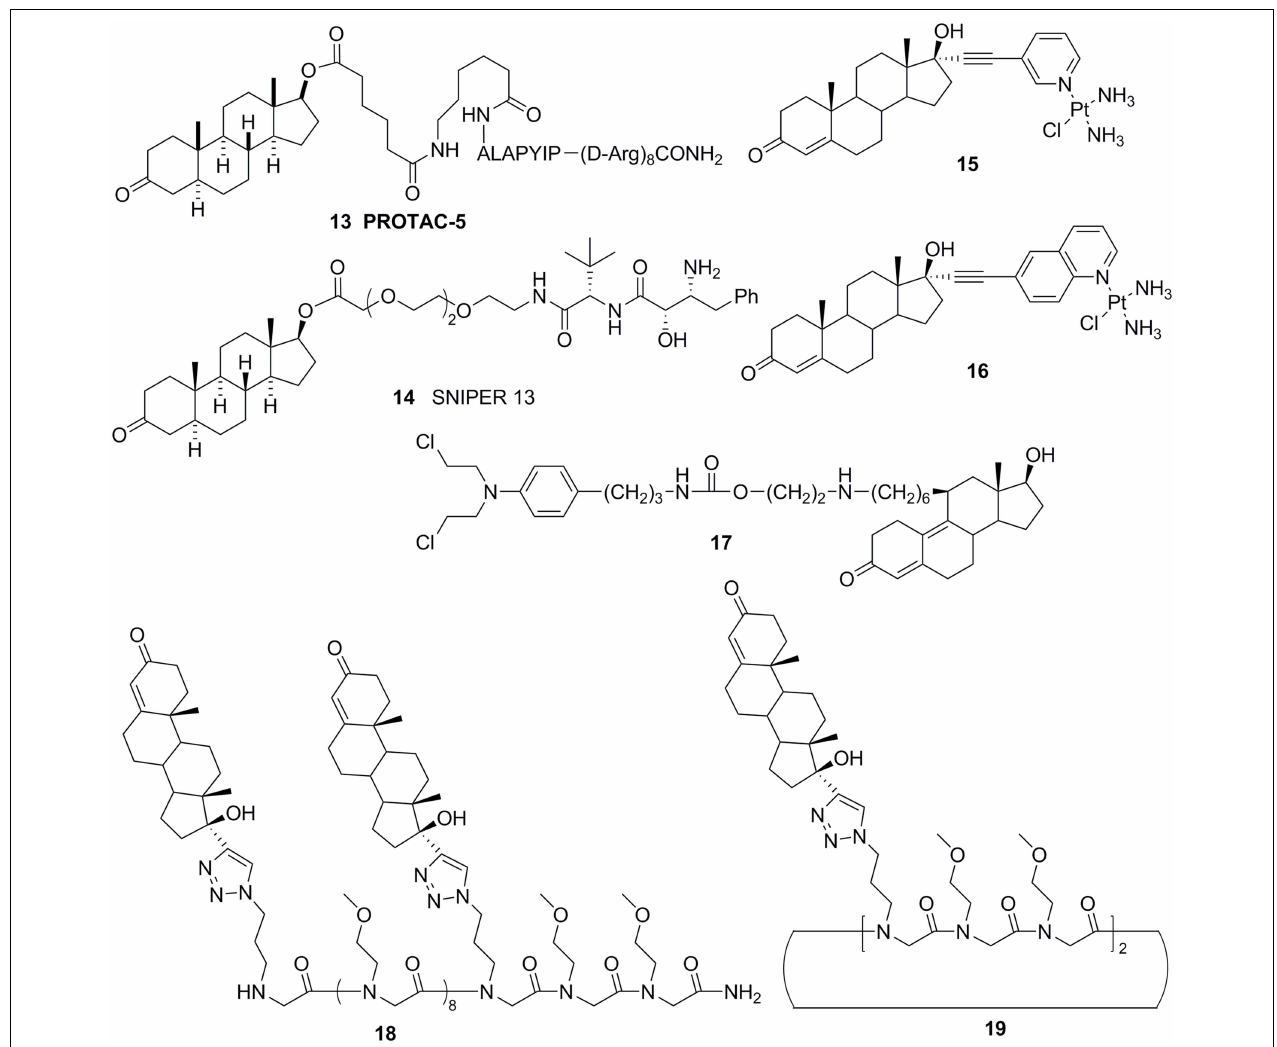
FIGURE 6 | Chemical structures of steroid conjugate AR